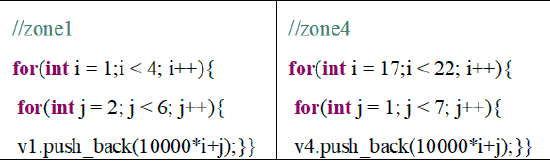
Figure 12. Zone rotate seat number generation.